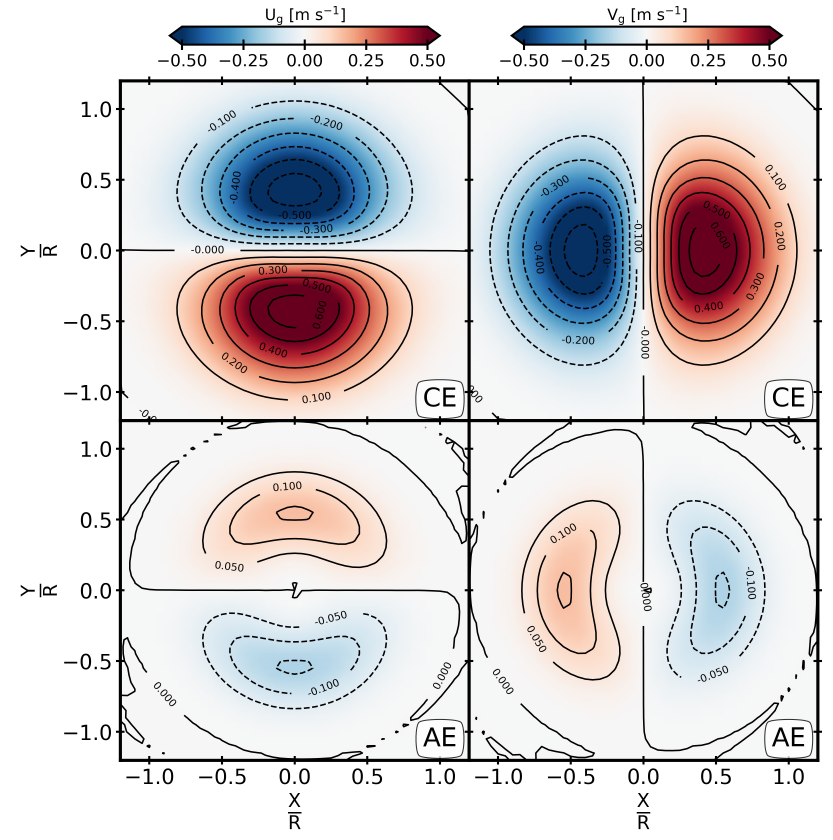
Figure 14. The geostrophic velocity components U g and V g of the CE and AE. Using the Q-omega equation, we compute the frontogenesis vertical velocity w b (Figure 15). The vertical velocity of each eddy is a dipolar structure with alternating upwelling (positive w b ) and downwelling (negative w b ) cells for the AE and CE. The alternating upwelling and downwelling cells in both eddies are related to the β -term, which is the most dominant process. Since this vertical velocity is averaged between the surface and 400 m, upwelling and downwelling processes associated with frontogenesis are deep-reaching. This vertical velocity is intensified for the CE, reaching 3 m day − 1 , while for the AE, it is slightly weakened, reaching 0.6 m day − 1 . This intensification of the CE vertical velocity can be related to a diffusive convection, as suggested by the Turner angle Tu, which is less than − 40 ◦ . Finally, the intensification of frontogenesis vertical velocity and its deep-reaching may suggest the presence of ageostrophic motions inside both